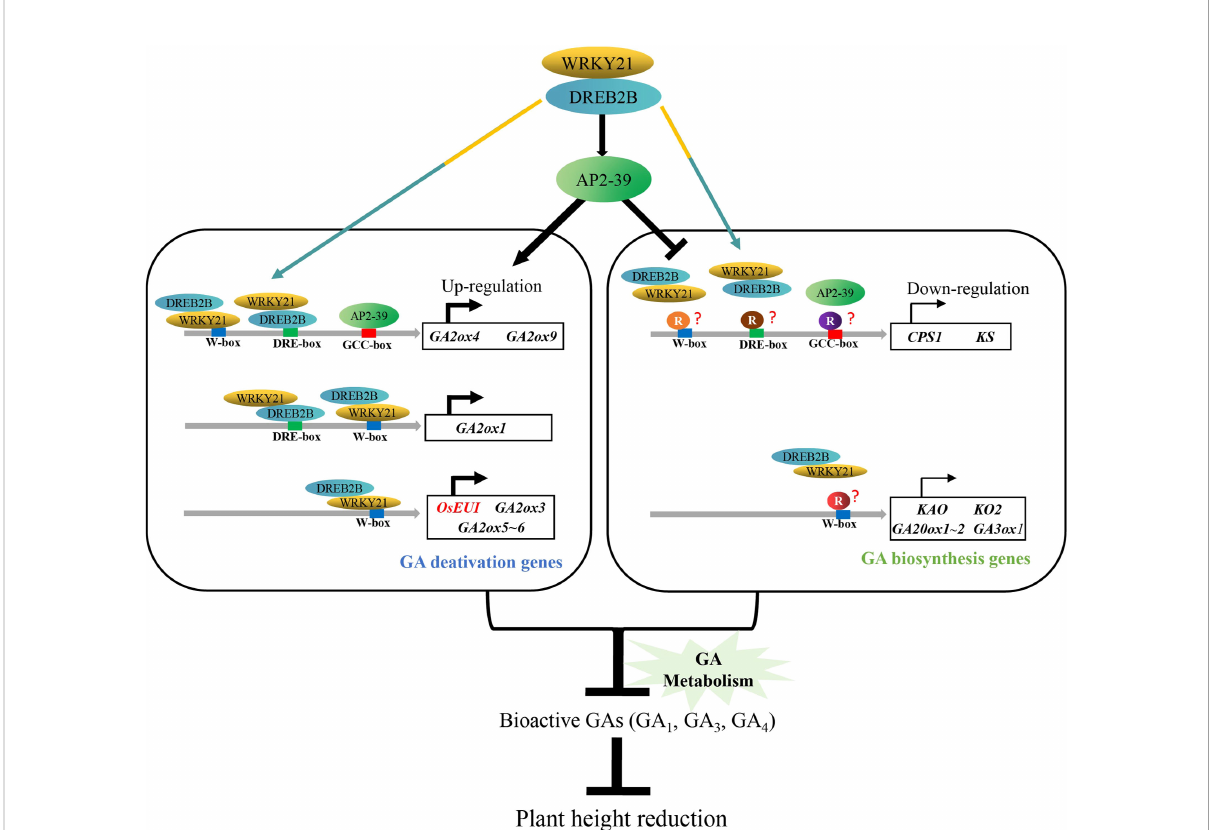
FIGURE 10 Proposed model of OsDREB2B regulatory mechanism in plant height reduction in rice. Colored spindles indicate different transcription factors, and colored circles indicate different repressors. Colored rectangles indicate the cis -element binding sequence. Colored arrows indicate that OsDREB2B/WRKY21 complex can bind directly to the cis -element (s) on the promoters of GA metabolic genes. The black arrows represent the activation effect, and the hammer lines indicate the inhibition effect. Curved arrows in the dark indicate the transcriptional expression of genes, and the thickness of the line represents the relative transcription level. Genes in red letters are based on experimental evidence, genes in black letters are based on bioinformatic